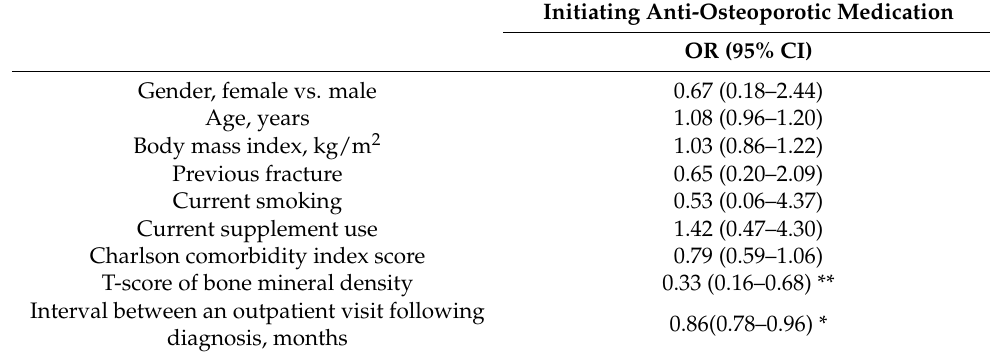
Table 4. Multivariable Cox proportional regression of the factors associated with initiating anti- osteoporotic medication ( n =